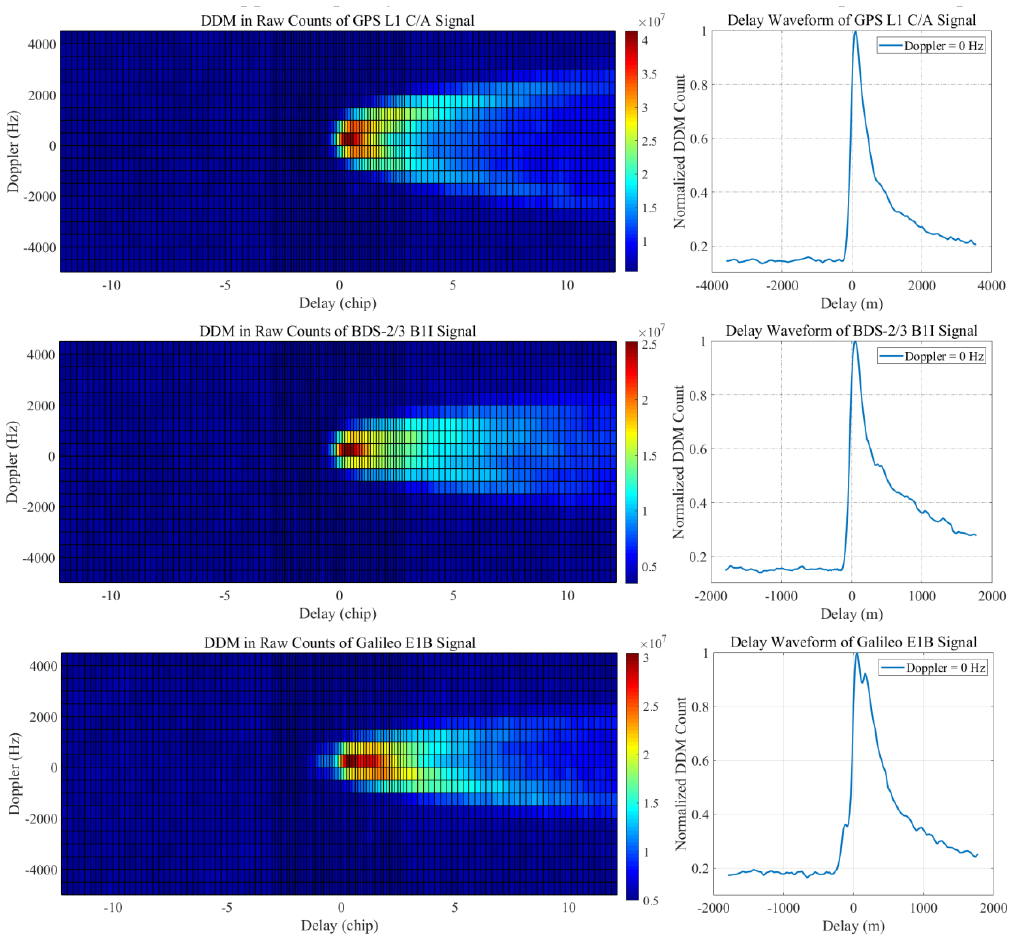
Remote Sens. 2023 , 15 , 745 14 of 19 Figure 9. Examples of DDMs in raw counts generated by the GNSS-R module of the GNOS-II on 11 July 2022 and its delay waveform corresponding to a Doppler of 0 Hz, corresponding to GPS ( Top , PRN 26), BDS-2/3 ( Middle , PRN 41), and Galileo ( Bottom , PRN 25), respectively. contained 411 DDMs on average and 920 DDMs at most. Figure 11 shows the global dis- The GNSS-R module of the GNOS-II can collect about 158,180 DDMs over the ocean, tribution of the specular point tracks of the FY-3E satellite in one day (17 July 2022). about 90,550 DDMs over the land, and about 41,623 DDMs over the ice, on average, each day during August 2022, with a 1 Hz DDM output rate. Figure 10 shows the number of tracks for each GNSS satellite from GPS, BDS-2/3, and Galileo in one day (17 July 2022), where a track is defined as a series of consecutive specular points corresponding to the same GNSS satellite. Based on the data on 17 July 2022, in terms of GPS, one track con- tained 579 DDMs on average and 1017 DDMs at most, and as far as BDS-2/3, one track contained 534 DDMs on average and 1000 DDMs at most. Regarding Galileo, one track